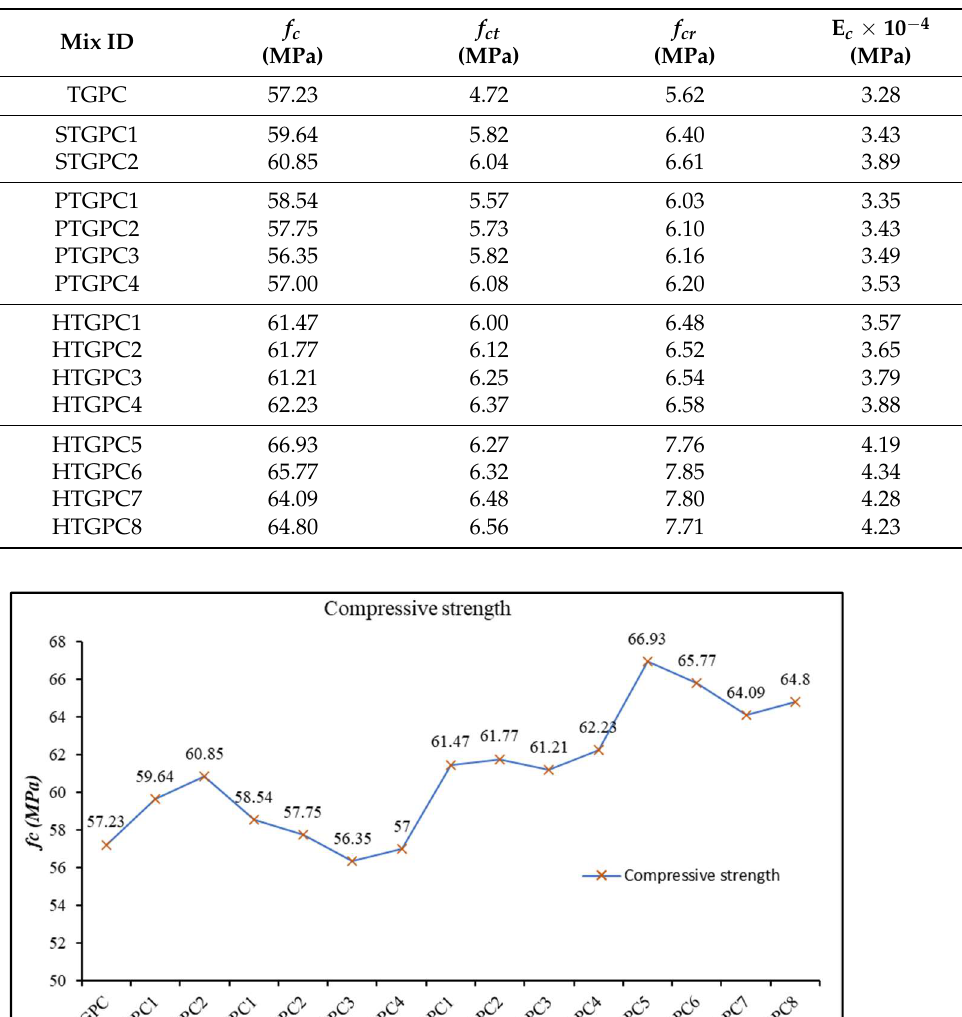
Table 7. Test results of hardened concrete.